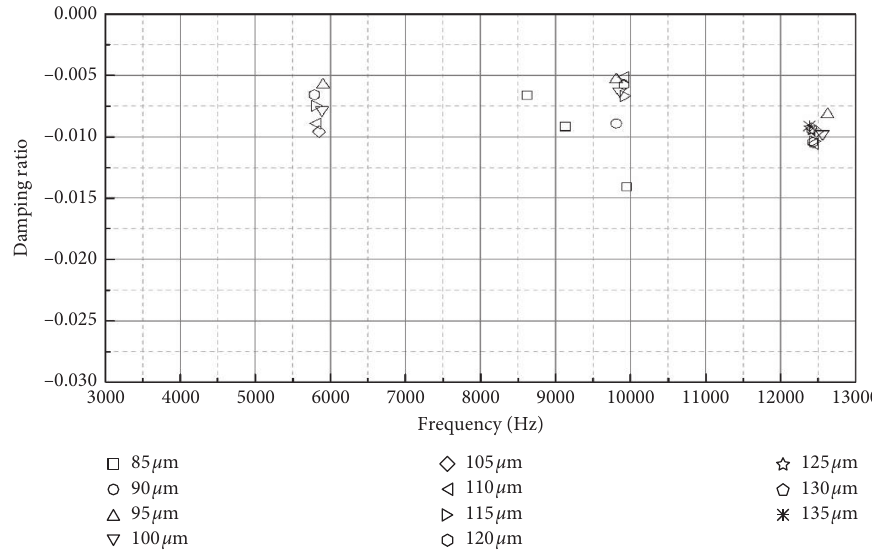
Figure 10: Noisy-mode distribution in Group D.